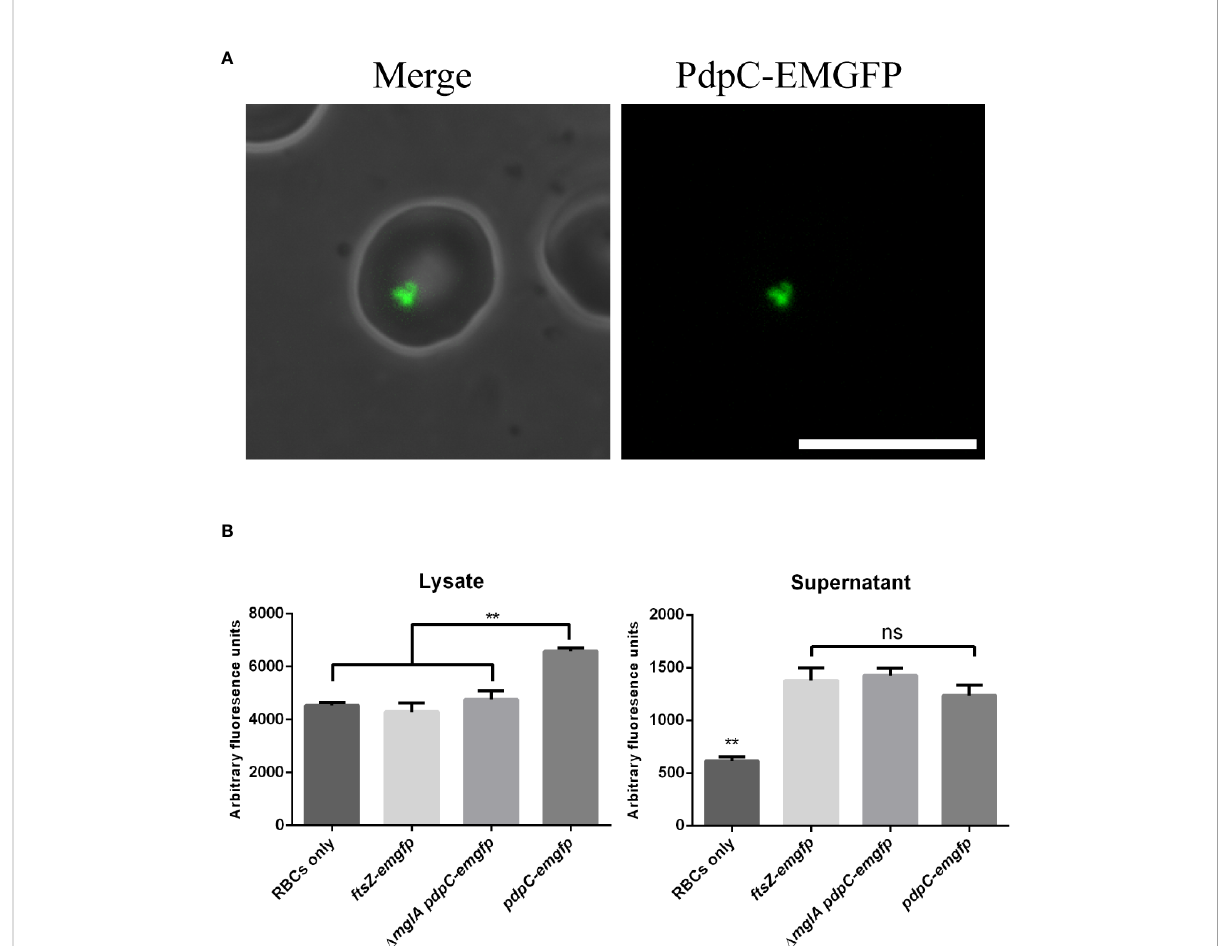
FIGURE 5 PdpC-EMGFP is secreted during erythrocyte invasion. (A) F. tularensis LVS strains expressing pdpC-emgfp were incubated with 3 x10 6 erythrocytes at an MOI of 100 for 24 hours and analysed by epi- fl ouresnce microscopy.PdpC-EmGFP fl uorescence could be seen in approximately 1% of erythrocytes. A total of 2071 erythrocytes were scored for fl uorescence over 4 independently conducted experiments. Scale bar equals 10 µm. (B) F. tularensis LVS strains containing either a vector with pdpC-emgfp or a vector expressing ftsZ-emgfp from FGRp were incubated with 1 x10 7 erythrocytes at an MOI of 100 for 24 hours. Erythrocytes were pelleted and lysed, fi lter sterilized to remove any bacteria and the fl uorescence of the lysate (top panel) and supernatant (lower panel) was measured. The fl uorescence in lysates from erythrocytes incubated with wt F. tularensis LVS expressing pdpC - emgfp was signi fi cantly higher than that from erythrocytes incubated with either an mglA mutant expressing pdpC-emgfp or the wt strain expressing ftsZ-emgfp (** p < 0.05 determined by ordinary 1-way ANOVA